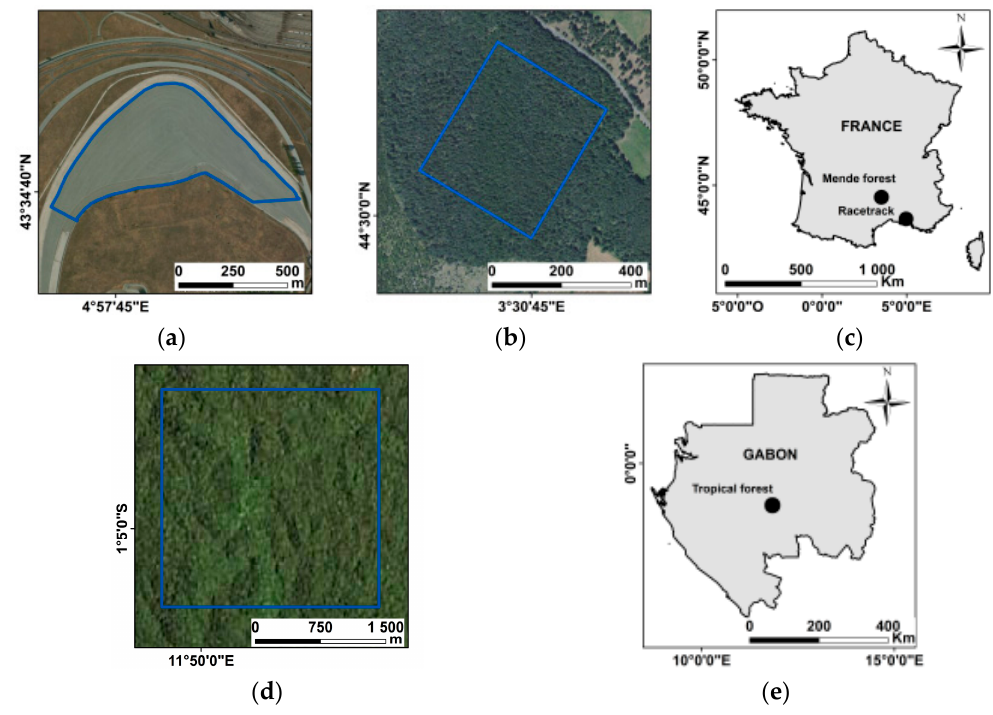
Figure 1. Locations of the three invariant targets. ( a ) Racetrack; ( b ) Mende forest; ( c ) location of the racetrack and the Mende forest targets in France map; ( d ) Gadon forest; ( e ) location of the Gabon forest target in Gabon map.